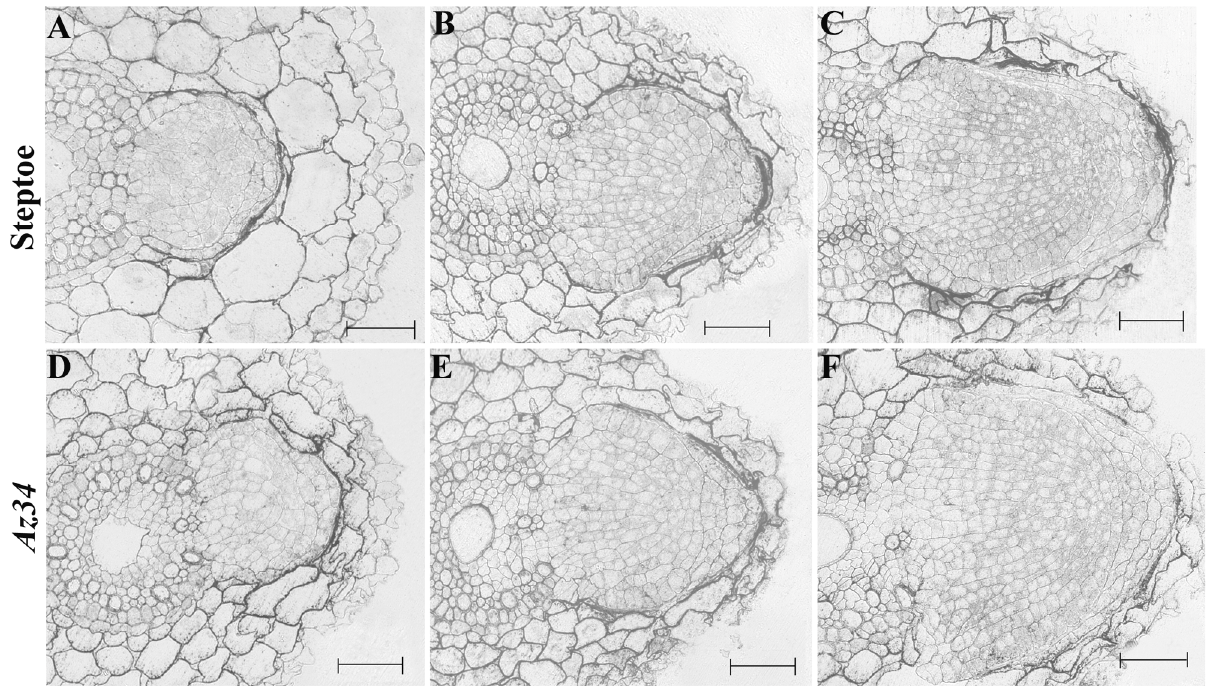
Figure 3. Immunostaining of ABA in root primordia of Steptoe ( A – C ) and Az34 ( D – F ) at successive stages of their development. Scale bar is 50 µm.